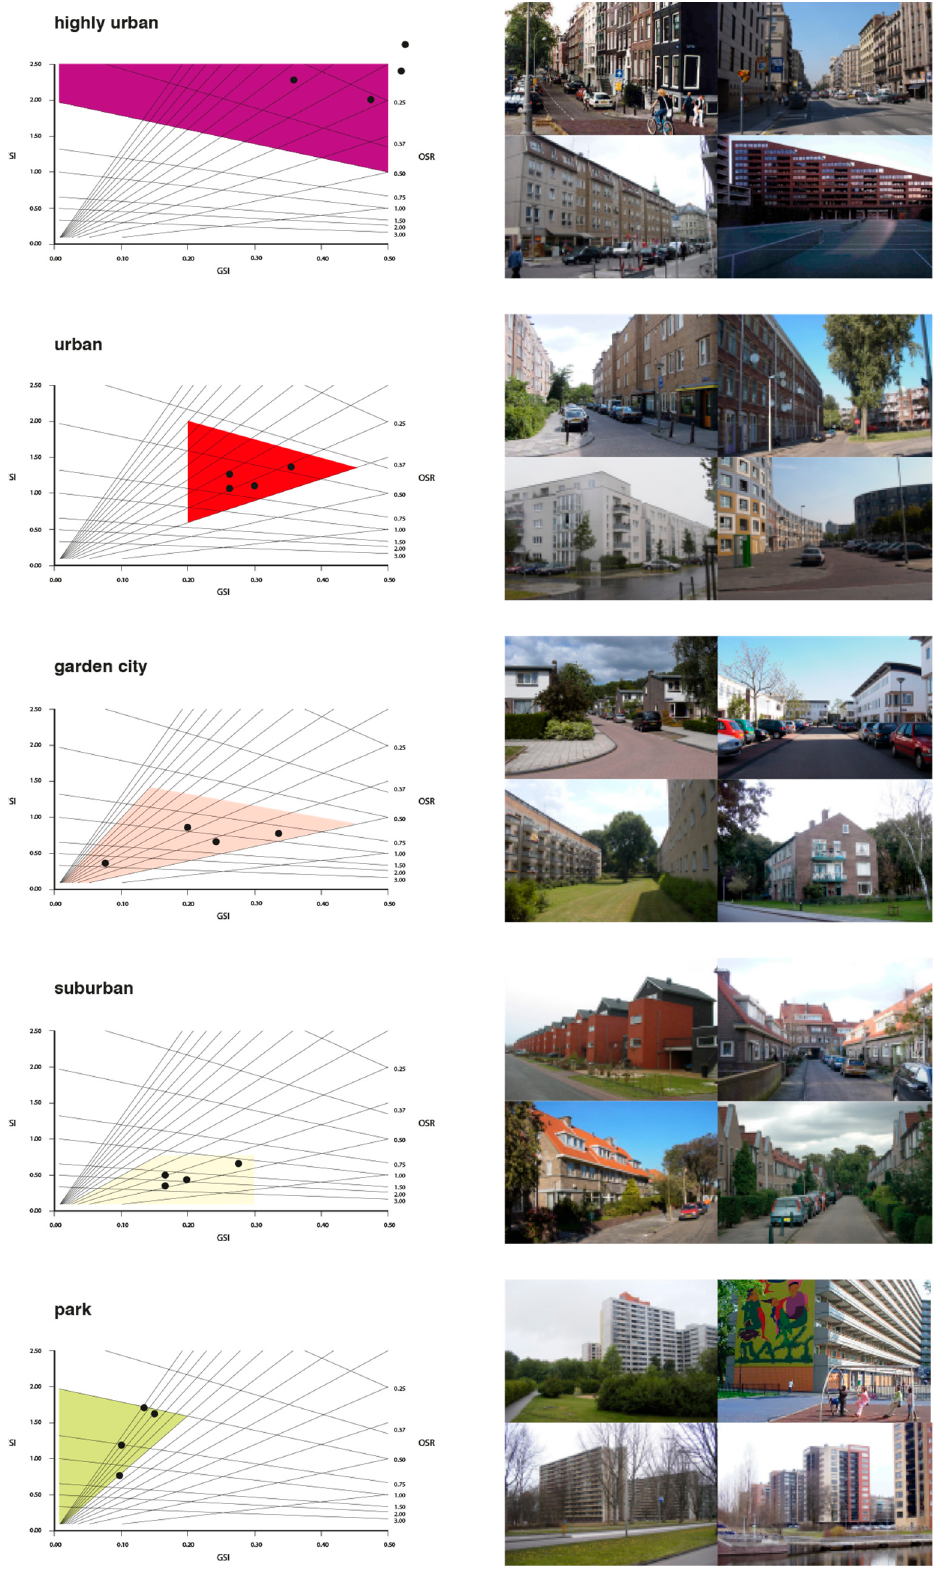
Figure 1. Types of buildings in Space matrix. Source: [18]. The gradation and systematization of various building typologies is also the basis of the urban-to-rural transect (hereinafter: transect) methodology introduced by Andreas Duany from the DPZ CoDESIGN (Duany & Plater-Zyberk architectural practice) [19].